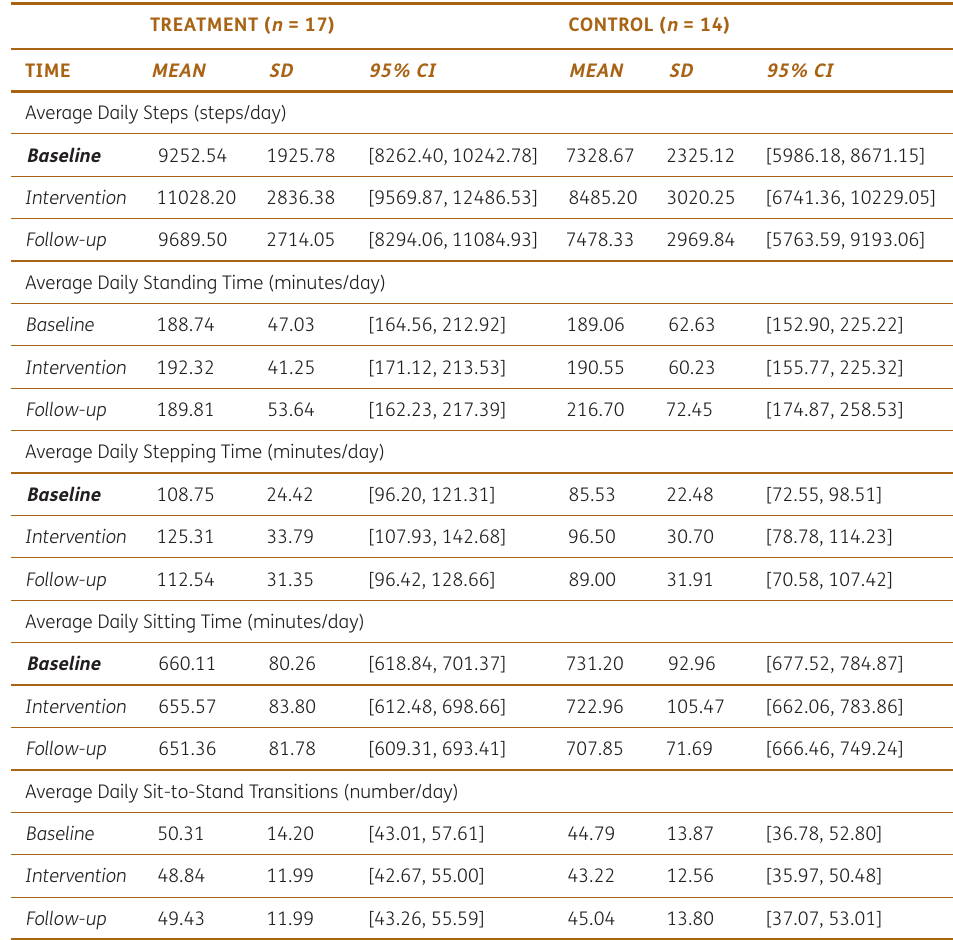
Table 2 Means, standard deviations, and 95% confidence intervals for device-measured sedentary behaviors throughout the study. Note: Bold text indicates significant differences between groups at baseline ( p < 0.05)